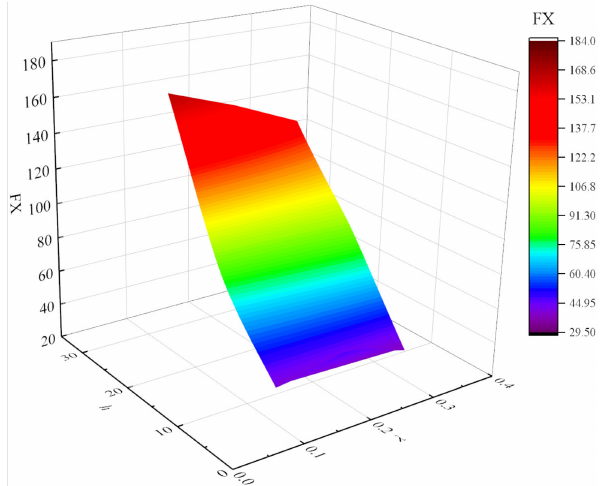
Figure 19. Influence of λ and h on the traction